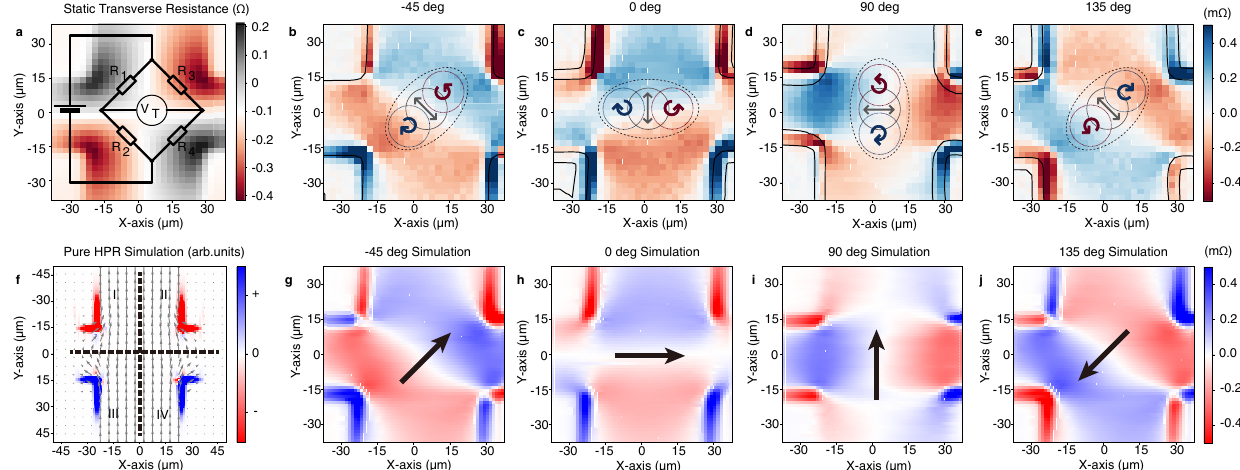
Fig. 2 | Beam shift-induced transverse photoresistance with a Wheatstone bridge model. a The static component of the 2Dtransverse resistance mapping of thePtHallcrosscanbeviewedasaWheatstonebridgewithfourresistorsR1,R2,R3, and R4. The temperature rises in areas illuminated by the laser spot, which increasestheresistance.ThetransversevoltageispositivewhenR1orR4increases, and negative value when R2 or R3 increases; b – e Transverse photoresistance mappingmeasuredatdifferentsampleorientations. f Anillustrationofasimulated pure helicity-dependent photoresistance (HPR) effect, along with the charge cur- rent distribution shown as gray arrows. The spin accumulation is assumed to be proportional to the curl of the current along the transverse direction in a high-